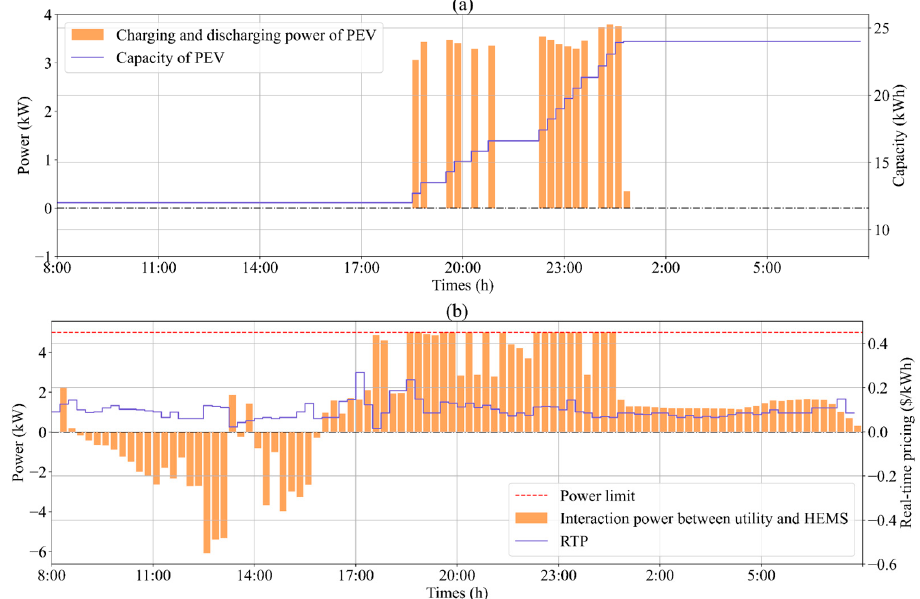
Figure 10. Load profiles for ( a ) PEV in G2V mode and ( b ) H ‐ MG without mode segmentation strat ‐